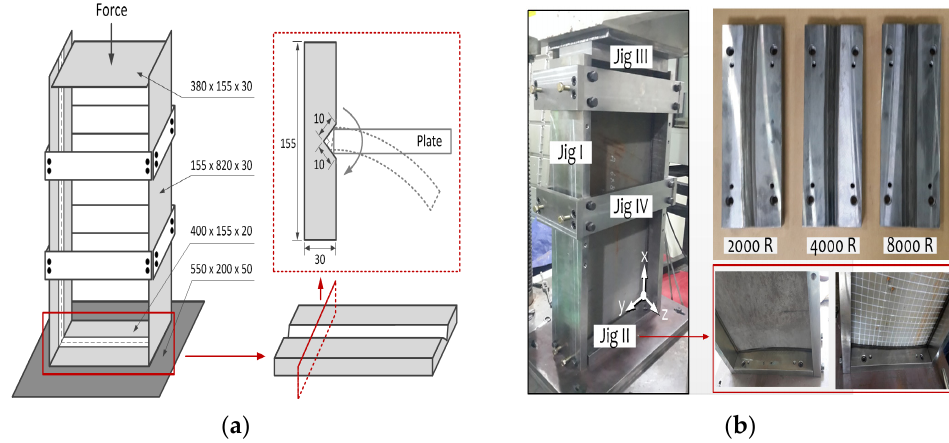
Figure 3. ( a ) Schematic overview of the experimental jig and ( b ) image of the testing jig.